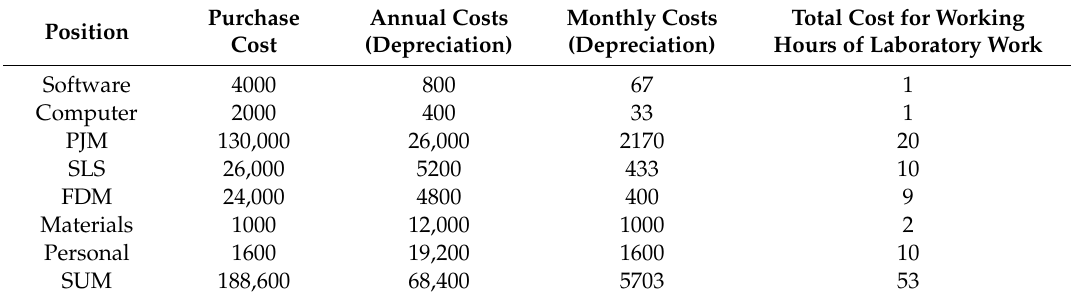
Table 3. Cost estimations of the basic elements needed for the rapid prototyping